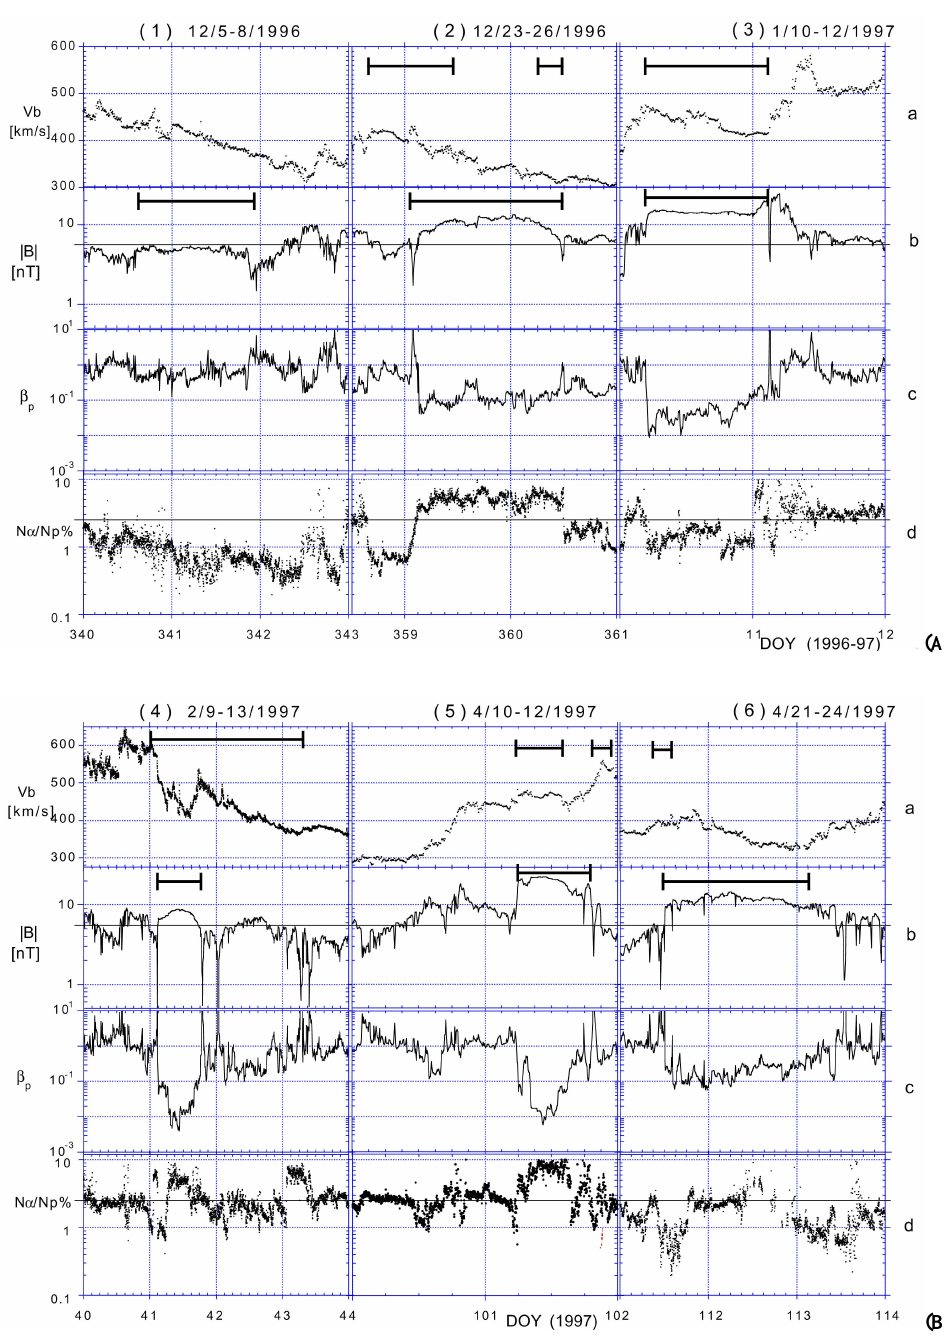
Fig. 6. Candidate ejecta intervals, at 1AU, are ordered chronologically from left to right. On top of each panel-column, for each event, its order-number and interval of solar wind observation is given. Panel (a) shows solar wind velocity and horizontal bar indicates times when Tp < 0 . 5 T expected ; Panel (b) shows magnitude of the interplanetary magnetic field, horizontal bar indicates largest time interval of a slow rotation of its orientation, and horizontal line indicates historical mean value of 5.5nT. Panel (c) shows the β p plasma parameter; Panel (d) show the percentage alpha to proton relative abundance Nα/Np %, the historical average value ( ∼ 2.3% for a slow solar wind) is indicated by the horizontal